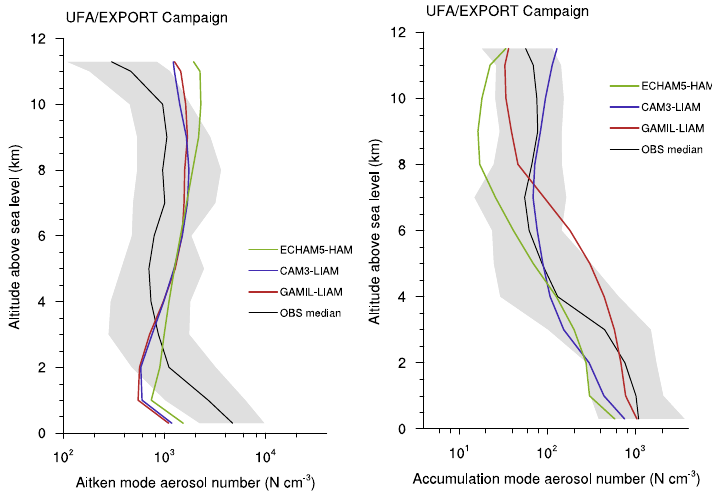
Fig. 10. Comparison between the simulated and observed Aitken (left) and accumulation (right) mode number concentrations over Europe. The simulated profiles are July and August averages in the red box shown in Fig. 8. The observations were compiled by Minikin et al. (2003) using the measurements obtained in July and August 2000 during the UFA/EXPORT campaign. The boundaries of the shaded areas indicate the 10th and 90th percentiles of the observational